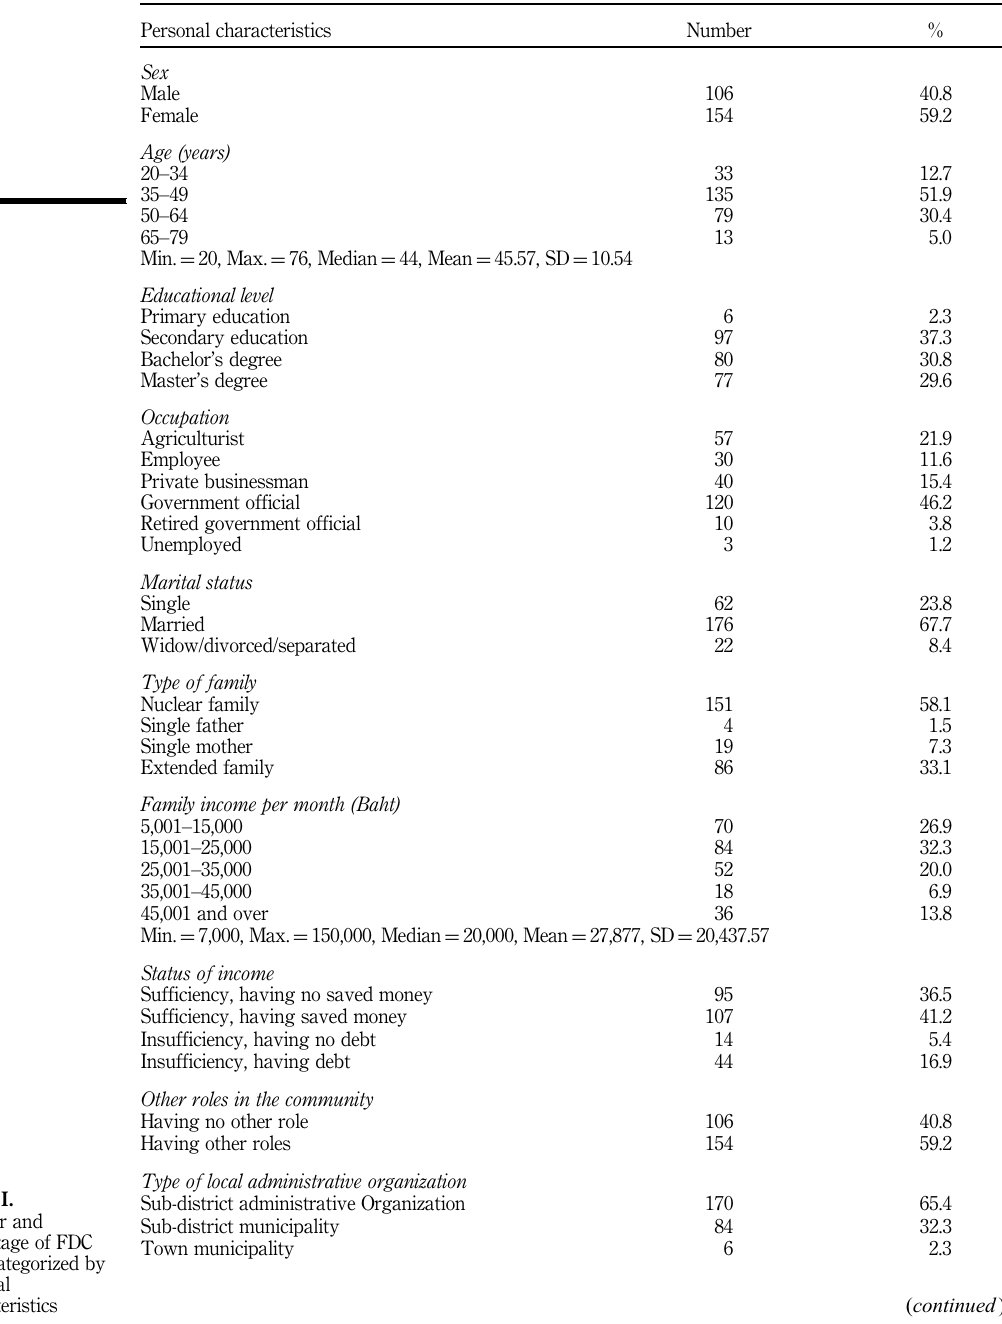
percentage of FDC staff, categorized by personal